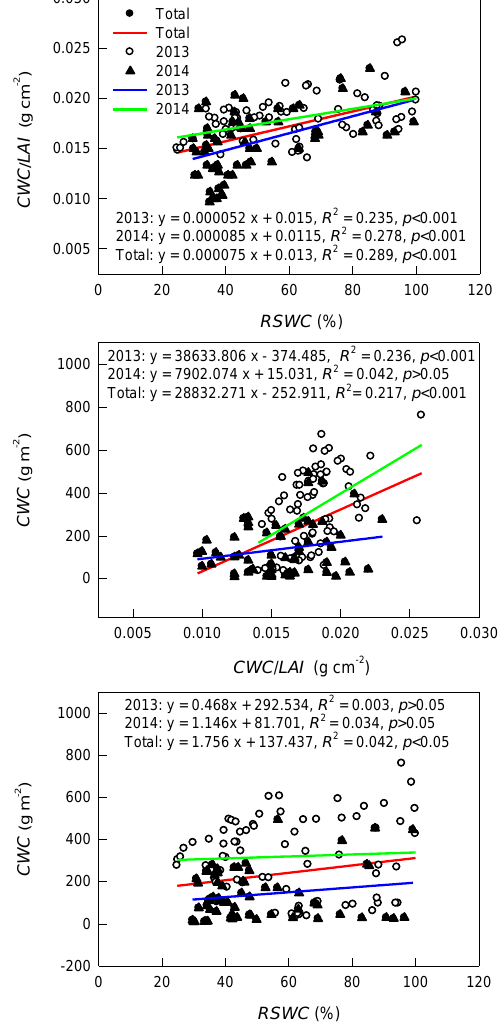
Figure 5. Relationships between CWC , 𝐸𝑊𝑇̅̅̅̅̅̅̅ ( CWC / LAI ), and RSWC for maize during the growing seasons of 2013–2014. Figure 2 provides the definitions of